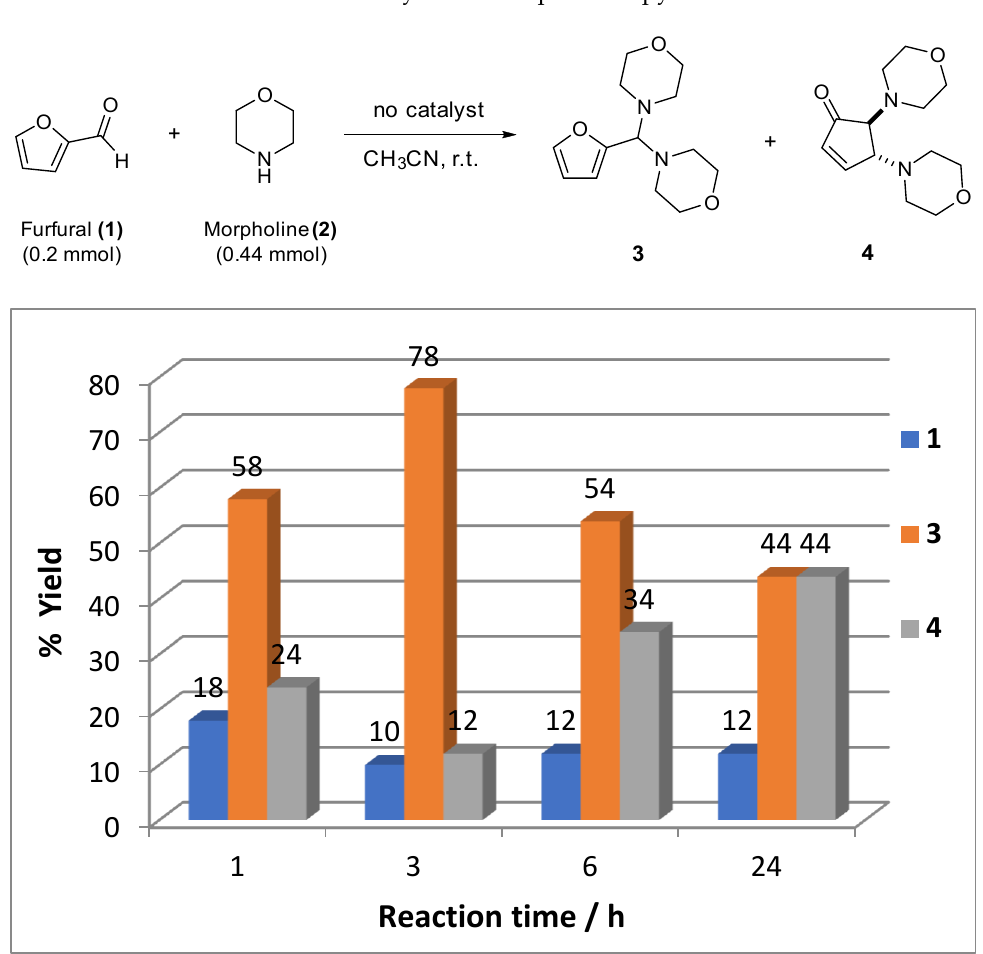
Figure 1. Reaction profile study in the absence of a catalyst and in CH 3 CN.